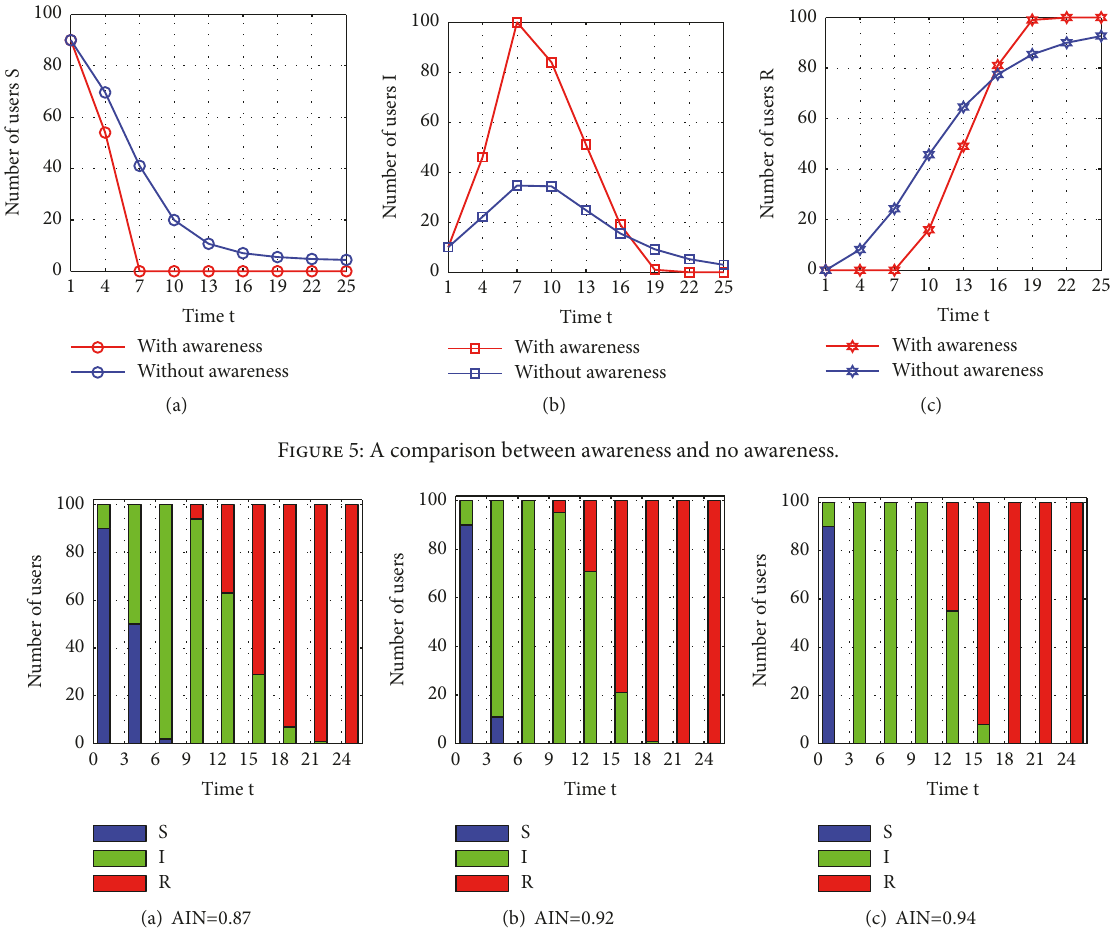
Figure 6: The impact of user influence on information diffusion